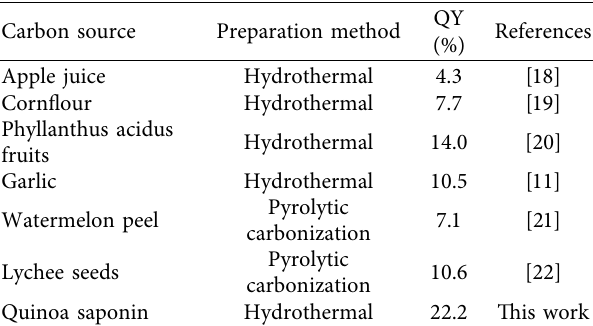
Table 1: Comparison of the proposed CQDs with various reported biomass carbon